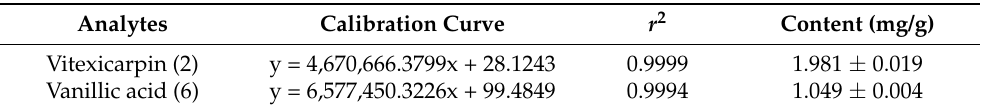
Table 1. Calibration curve and contents of compounds in V. rotundifolia fruit.